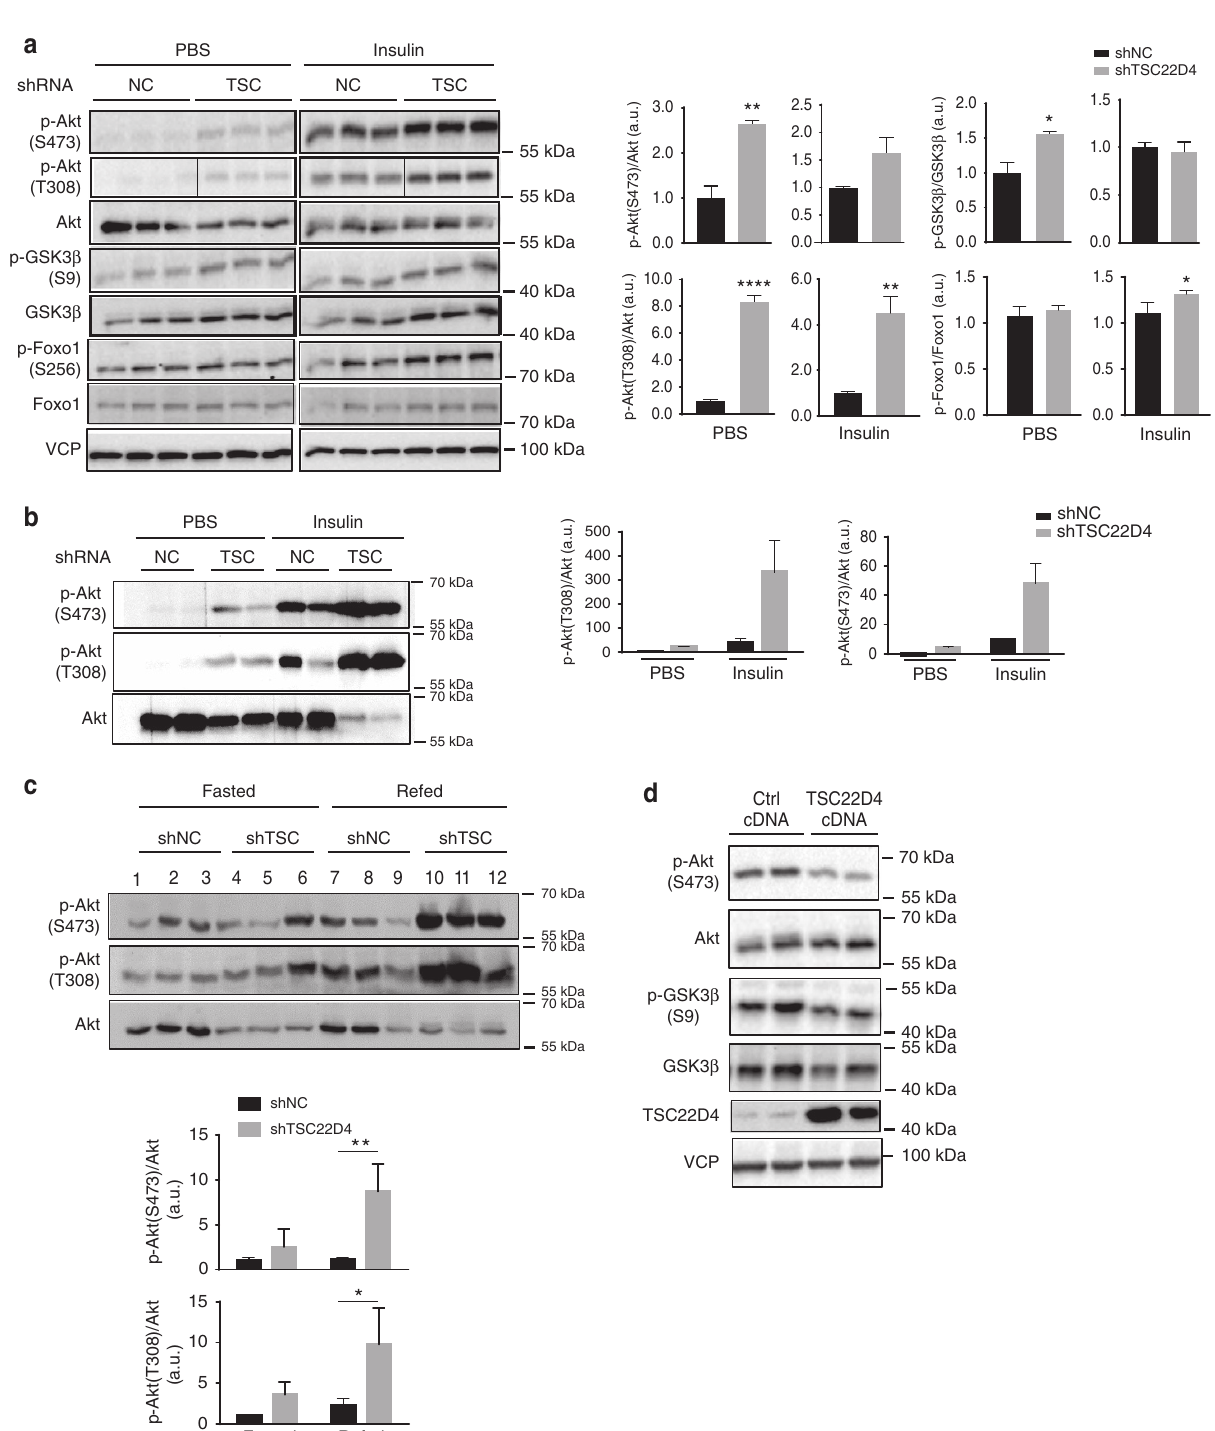
Figure 1 | TSC22D4 controls intra-hepatic insulin signalling. ( a ) Western blot analysis from representative negative control (NC shRNA) or TSC22D4 (TSC shRNA) shRNA adenovirus-treated primary mouse hepatocytes using indicated antibodies. Right: quantification of the phospho-immunoblots normalized to corresponding total protein levels ( y axis is in arbitrary units). Statistical analysis: Student’s t -test. * P r 0.05; ** P r 0.01; *** P r 0.001. Error bars indicate standard error of the mean (s.e.m.). ( b ) Western blot analysis of liver extracts from representative control (shNC) or TSC22D4 (shTSC) shRNA adenovirus-injected C57Bl/6 mice 7 days after injection using indicated antibodies. Right: quantification of the phospho-immunoblots normalized to corresponding total protein levels ( y axis is in arbitrary units). Animals were injected i.p. with either PBS or insulin 20min before sacrifice. ( c ) Western blot analysis of liver extracts from 16h fasted or 30min refed control (shNC) or TSC22D4 (shTSC) shRNA adenovirus-injected C57Bl/6 mice 7 days after injection using indicated antibodies. Bottom: Quantification of the phospho-immunoblots normalized to corresponding total protein levels ( y axis is in arbitrary units). Statistical analysis: two way ANOVA with multiple comparisons test; ** P r 0.01; **** P r 0.0001. Error bars in b , c , indicate standard deviation (s.d). ( d ) Western blot analysis of liver extracts from representative empty control (ctrl cDNA) or Flag-TSC22D4 cDNA adenovirus-injected C57Bl/6 mice 7 days after injection using indicated antibodies. Following 18h of fasting, mice were refed for 6h before sacrifice. NATURE COMMUNICATIONS|7:13267|DOI: